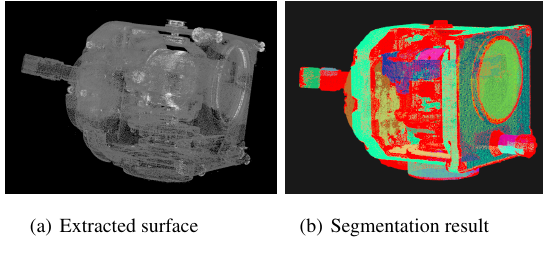
Figure 6. CT surface point cloud